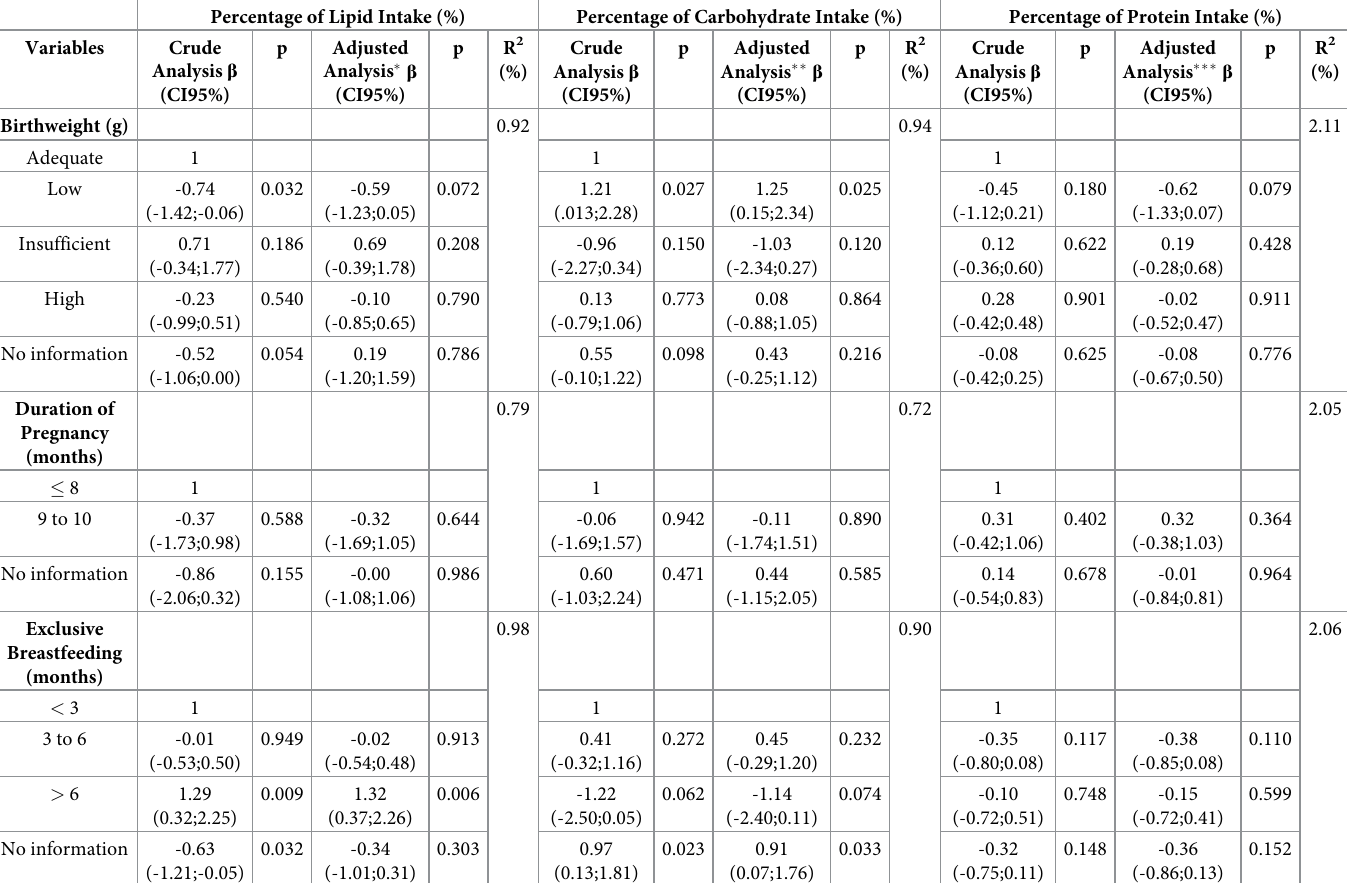
Table 3. Multiple linear regression between biological and behavioral factors in early life and percentage of lipids, carbohydrate and protein intake in Brazilian ado- lescents, ERICA 2013–2014.